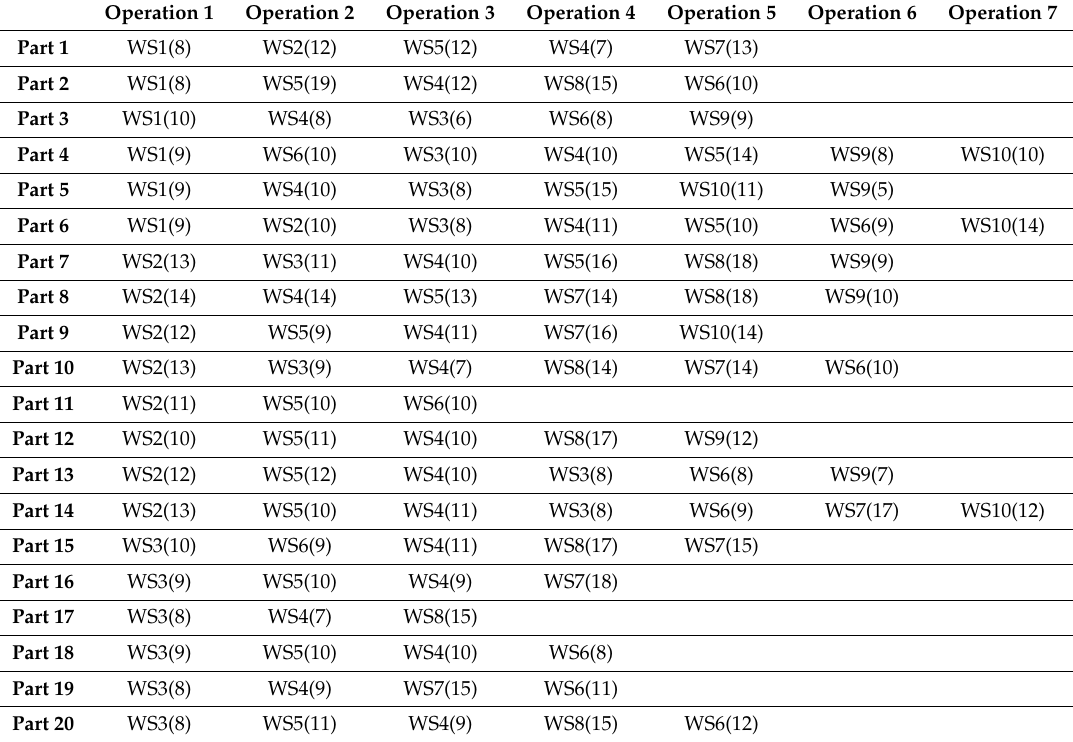
Table 2. Routes and Unit Processing Times of